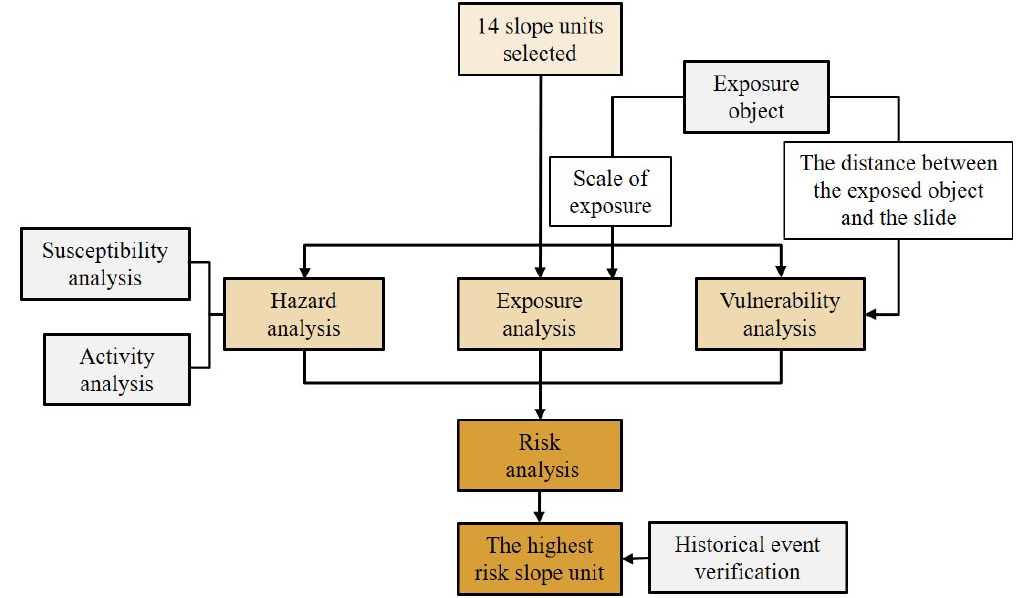
Figure 5. Improved framework of risk zoning for multi-slope units and the corresponding